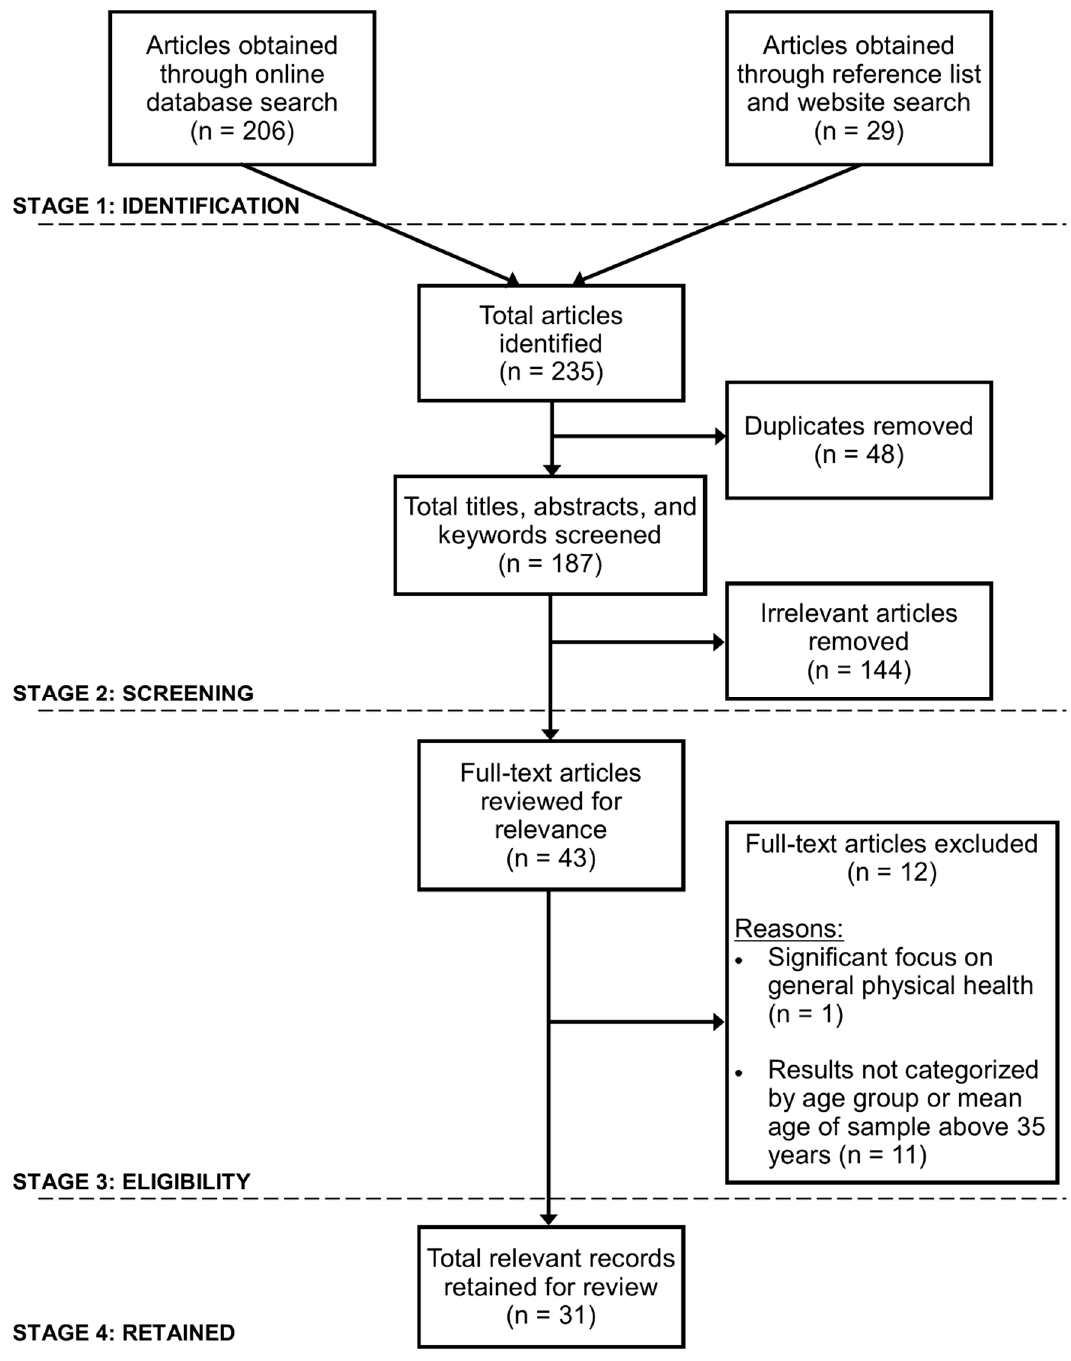
Figure 1. Flowchart of the literature search and selection strategy.